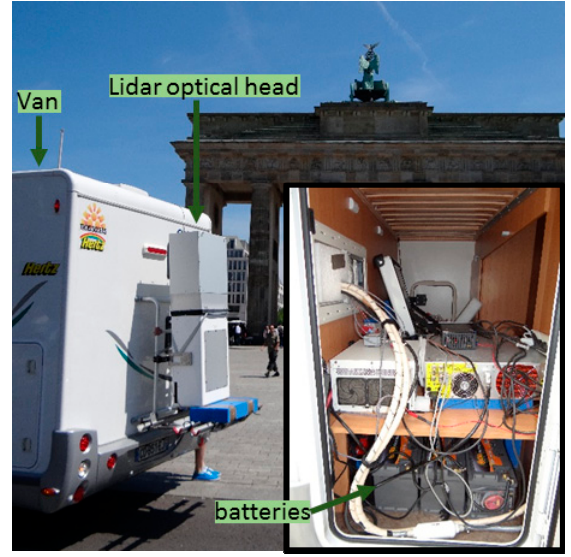
Figure 2. The van, in front of the Brandenburg Gate (Berlin), equipped with the N 2 -Raman lidar on its rear side. The inset photo shows the installation seen through the side door, with the power supply constituted of six 12 V truck-batteries (3 are visible on this side).